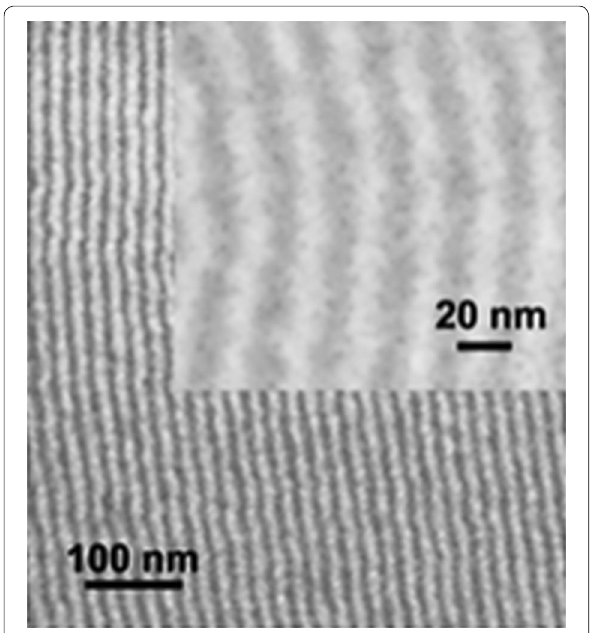
Fig. 12 SEM image of GNR array. Inset GNR under high magnification with nanoribbon width around 8 nm